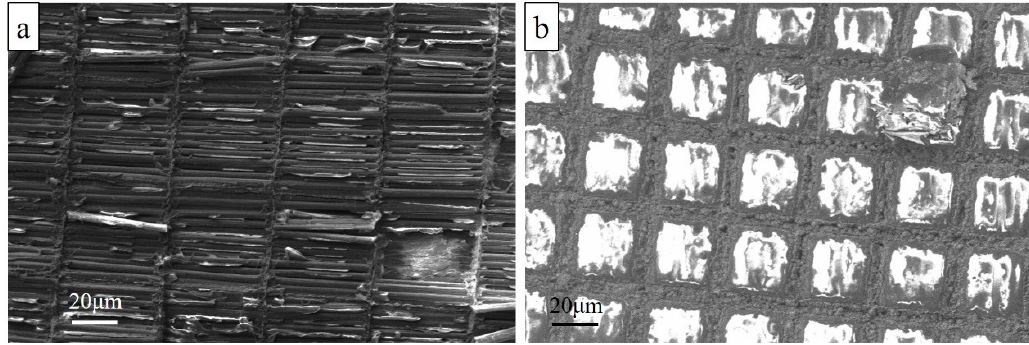
Figure 5. SEM images of ( a ) Femtosecond laser-treated carbon fiber reinforced plastic (CFRP) surface; ( b ) Femtosecond laser-treated aluminum surface.